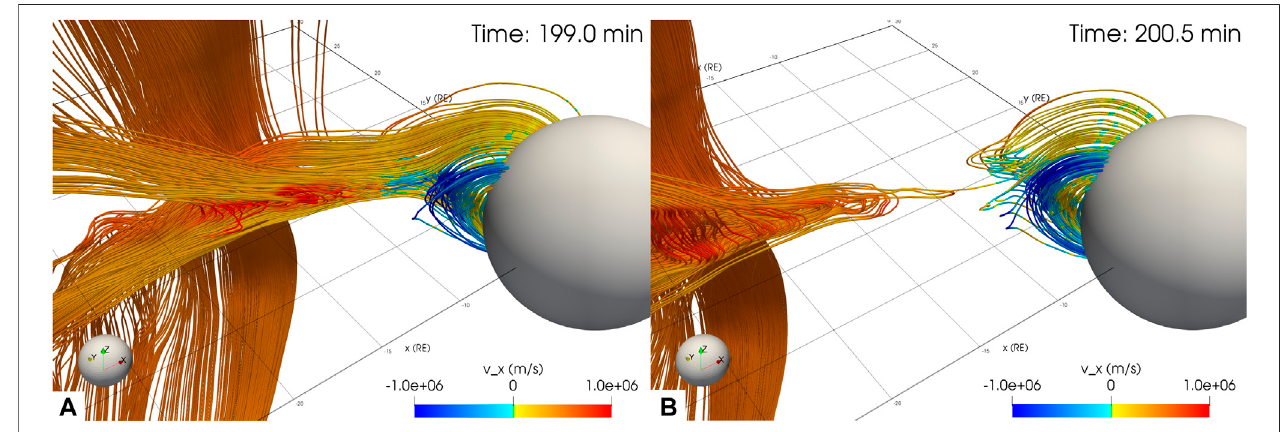
FIGURE 11 | The dissipation of fl ux ropes past the nightside reconnection region. Each panel is 1.5 min apart, and shows a view onto the dusk magnetotail of fl ux rope three.